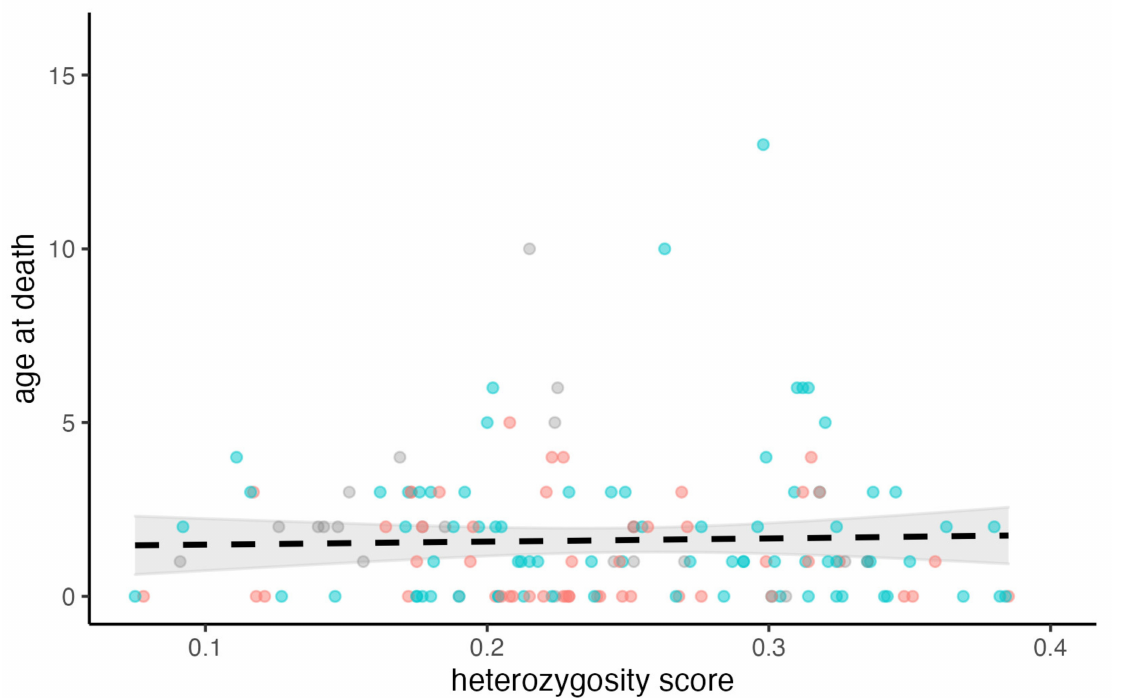
Figure 5. The relationship between individual heterozygosity (iH O ) and age-at-death of the hedge- hogs studied (N = 151) is not statistically significant. The red points represent females, the blue points males, and the grey points unknown sex. The line and ribbon represent the fitted model without sex included (sex does not influence the